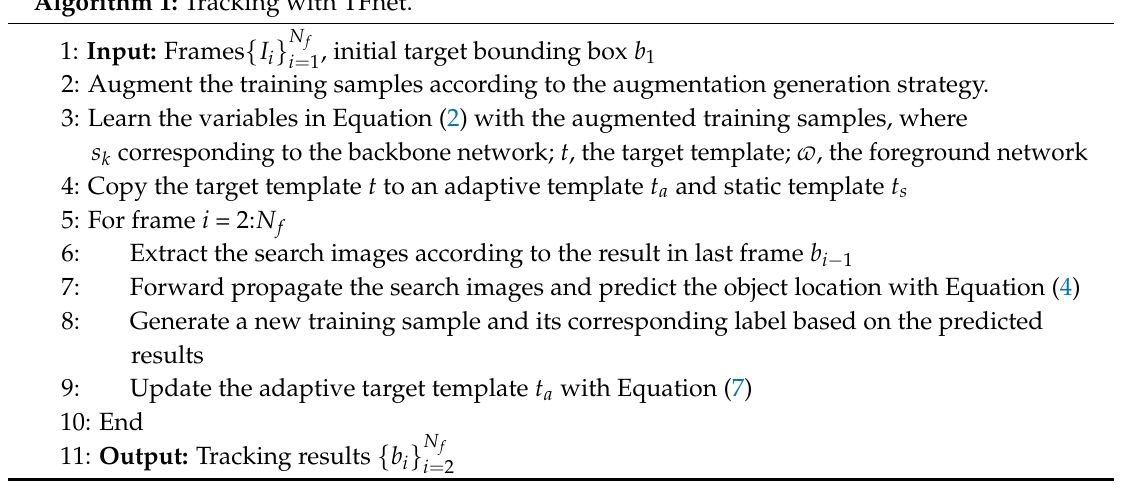
Algorithm 1: Tracking with